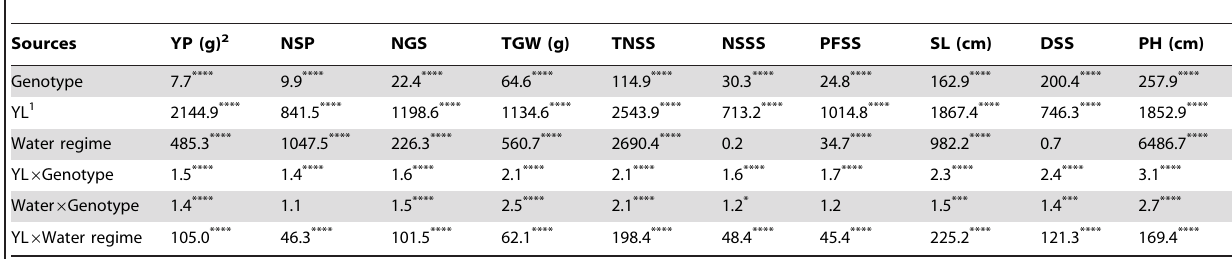
Table 4. F values of ANOVA-GLM for DH line genotypes and environments as well as their interactions.